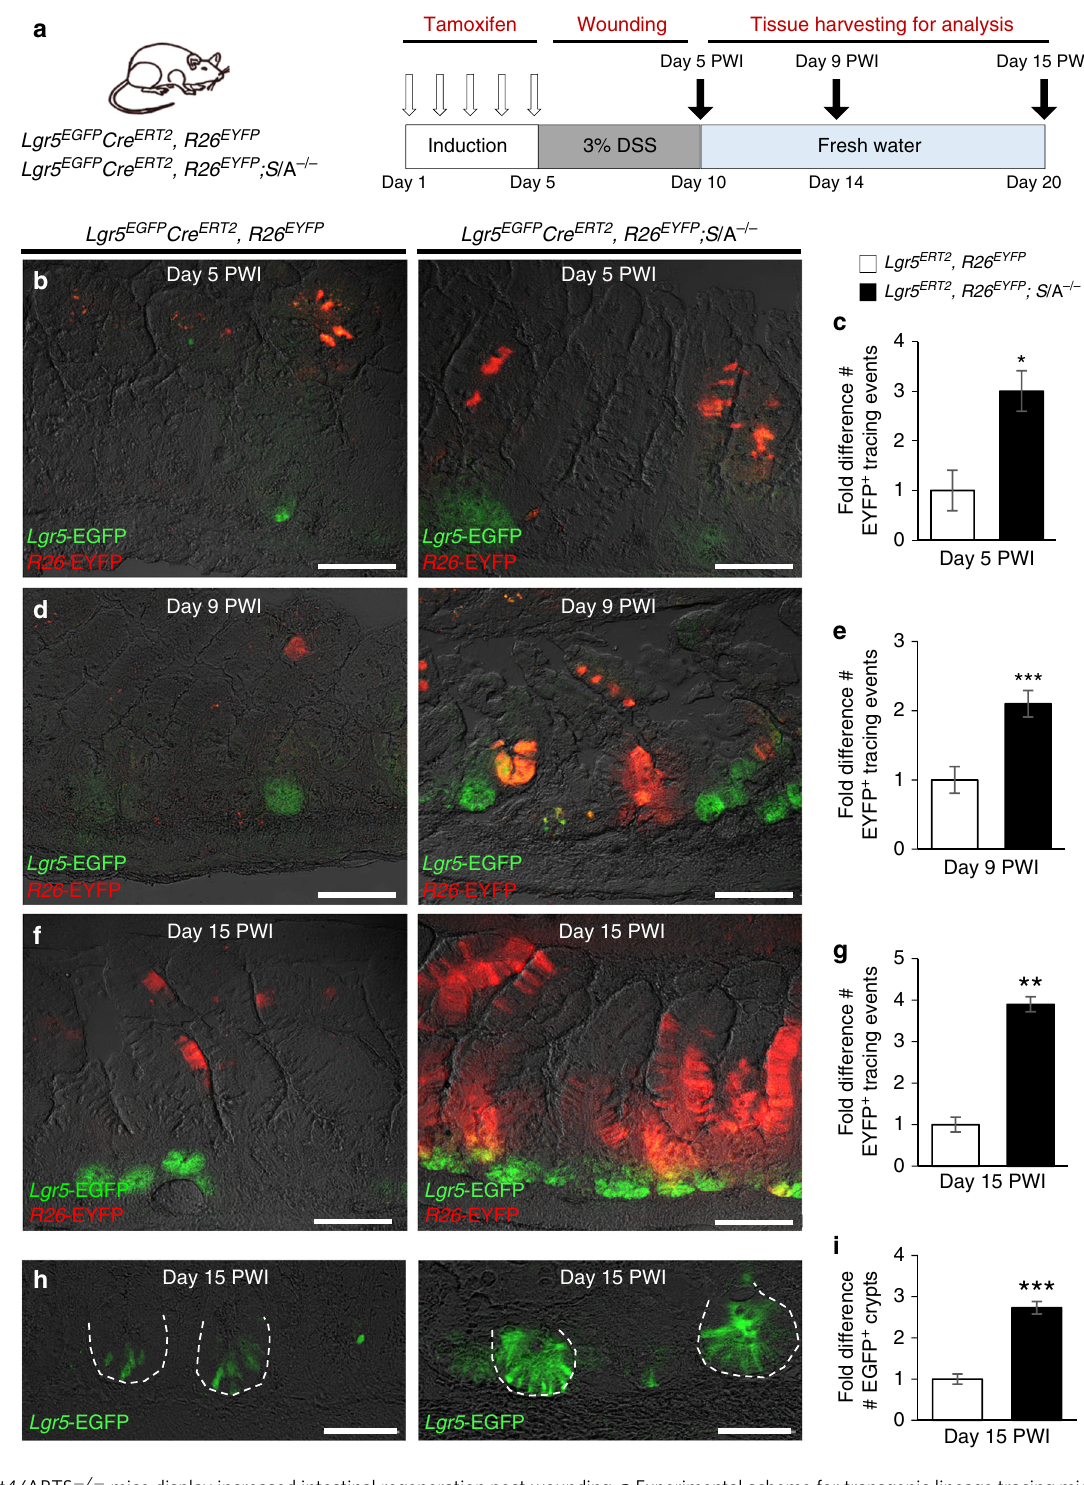
Fig. 7 Sept4 /ARTS − / − mice display increased intestinal regeneration post wounding. a Experimental scheme for transgenic lineage tracing mice, tamoxifen administration, dextran sodium sulfate (DSS)-mediated intestinal wounding and tissue harvesting. b – g Images and quanti fi cations for lineage tracing in control Lgr5 EGFP Cre ERT2 , R26 EYFP (denoted Lgr5 ERT2 , R26 EYFP ) and Lgr5 EGFP Cre ERT2 , R26 EYFP ; S /A − / − ( Lgr5 ERT2 , R26 EYFP ; S /A − / − ) terminal ileal tissues at b , c 5 days, d , e 9 days and f , g 15 days post wound in fl iction (PWI). Images show Lgr5 -EGFP + intestinal stem cells (ISCs) and their progeny expressing enhanced yellow protein (EYFP) under the Rosa26 ( R26 ) promoter ( R26- EYFP + ) during the post-wounding regenerative response. Quanti fi cations show fold difference in number of tracing events per time point PWI. h , i Images of h Lgr5 -EGFP + crypts in terminal ileum at 15 days PWI and i quanti fi cations of fold difference in number of regenerated EGFP + crypts at 15 days PWI. Dashed white line demarcates crypts. All images and quanti fi cations are representative of n = 3 mice per genotype per group. P values were determined by unpaired Student ’ s t test, where * P < 0.05, ** P < 0.01 and *** P < 0.005. Error bars represent ± s.e.m. All experiments were repeated twice. Scale bars: 50 µ m ( h ), 100 µ m ( b , d , f